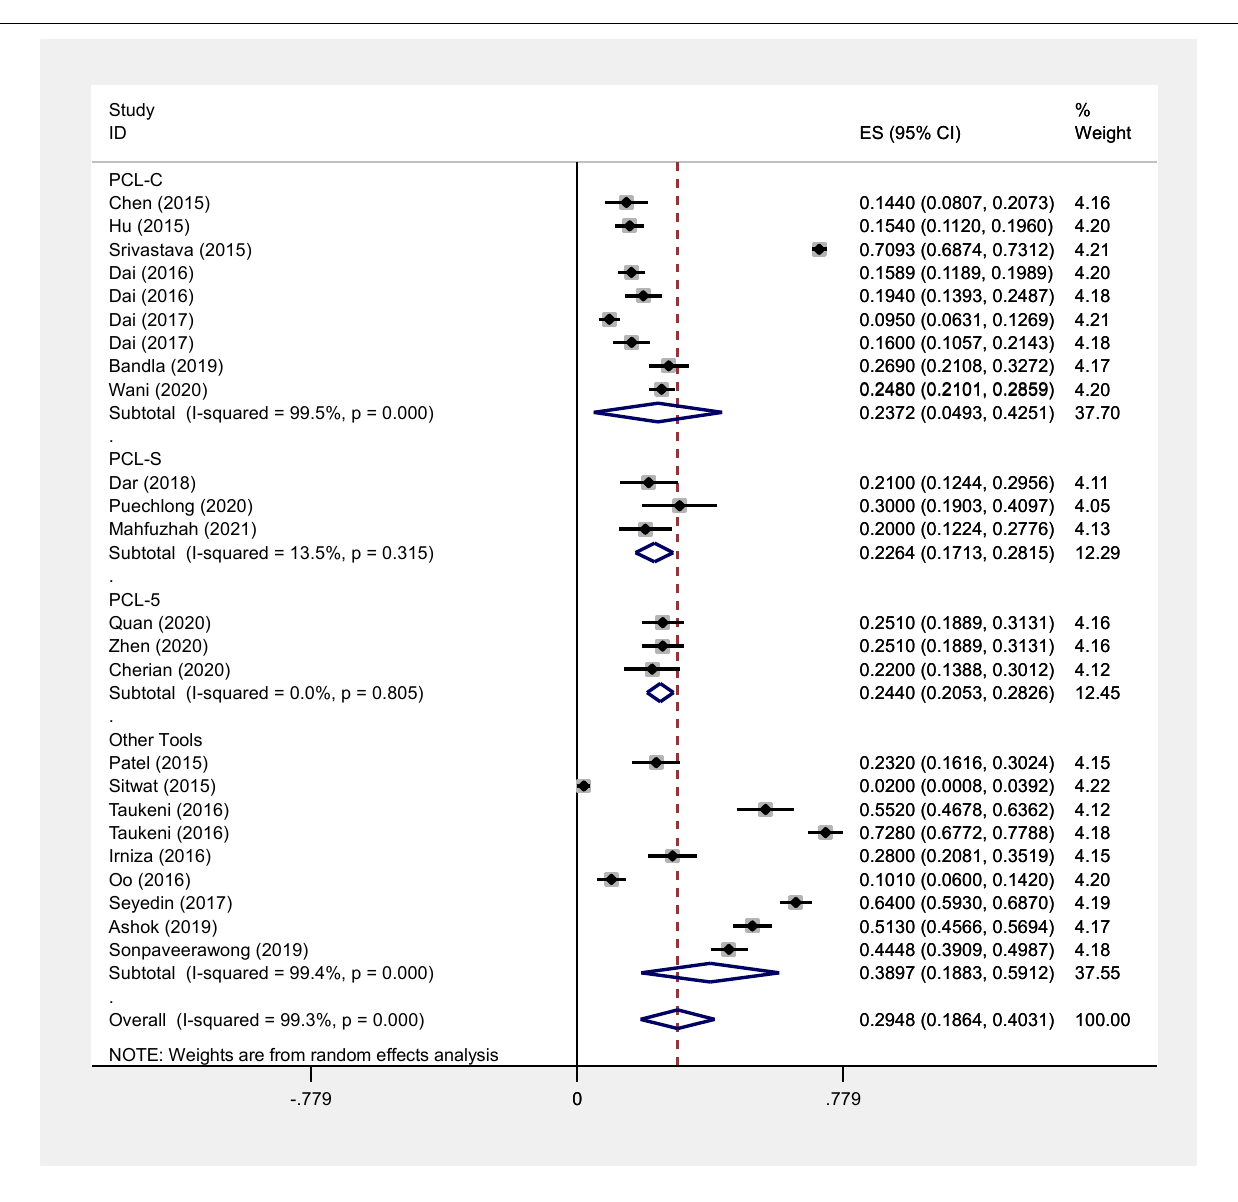
study was weighted according to its inverse variance. Due